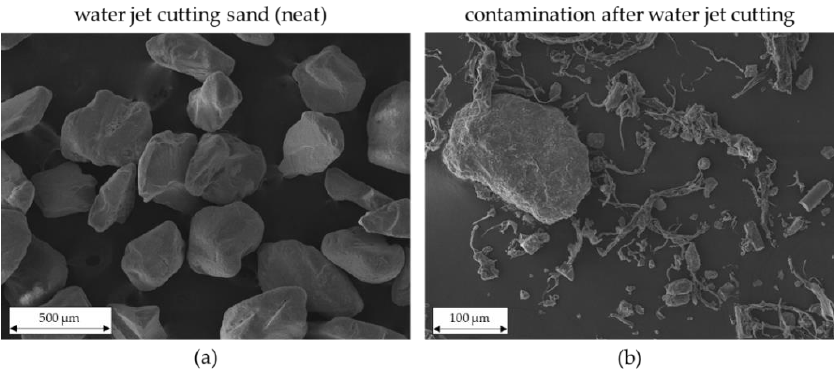
Figure 7. SEM images ( a ) neat waterjet cutting sand; ( b ) contamination found in the flakes after waterjet cutting.